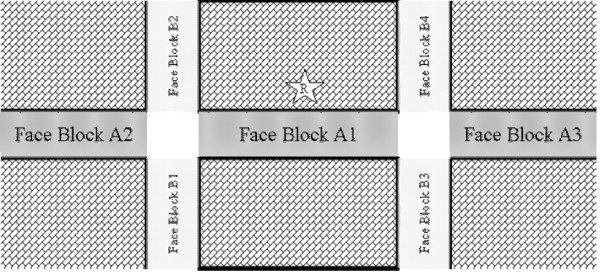
Block face diagram.